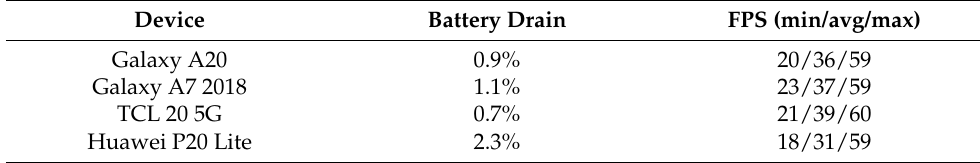
Table 3. Average results of 10 tests of 10 box question sessions.